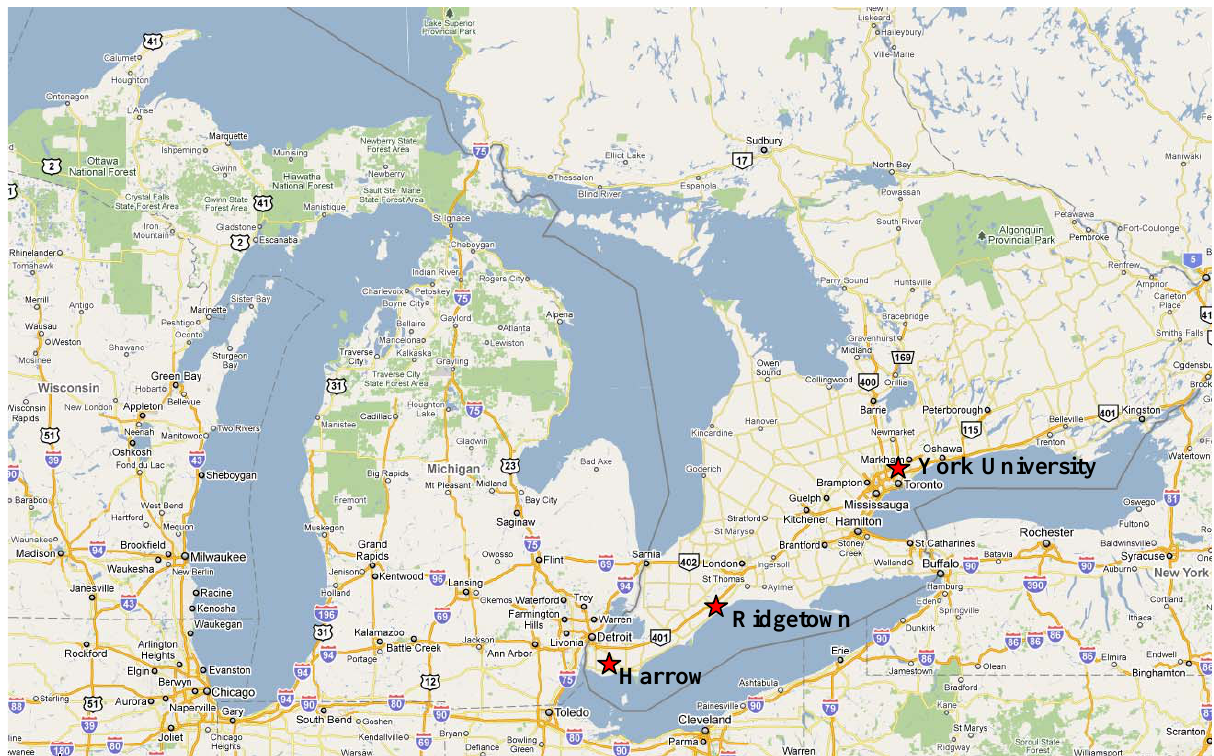
Fig. 1. Location of sampling sites.